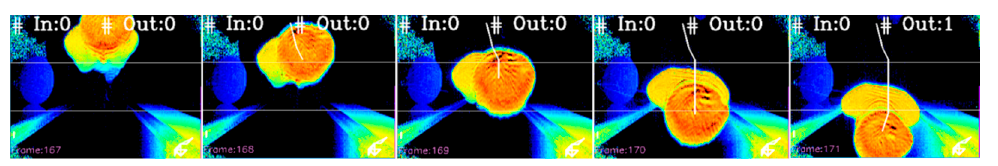
Figure 7. Schematic representation of the counting strategy.